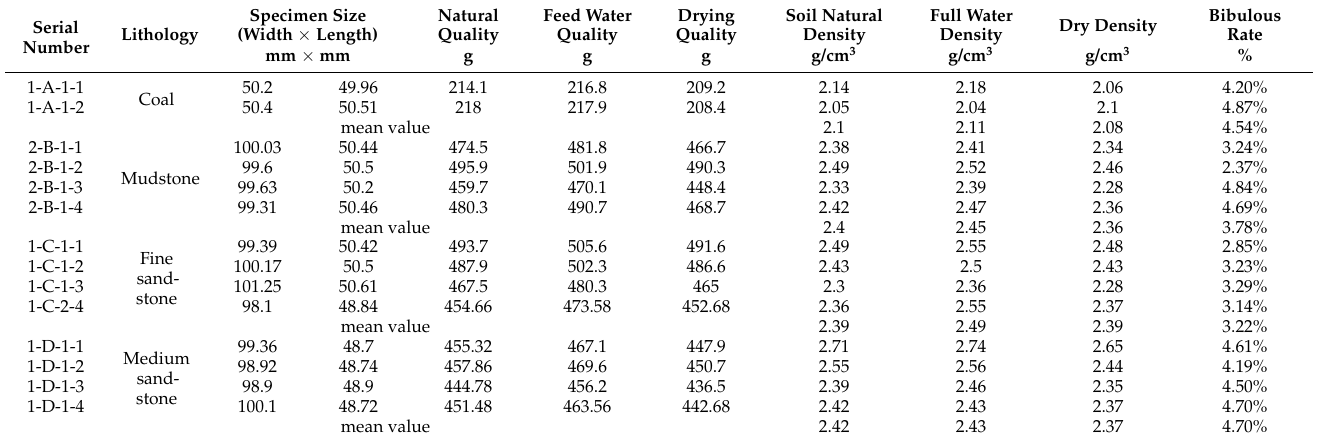
Table 1. Density and water absorption calculation table.